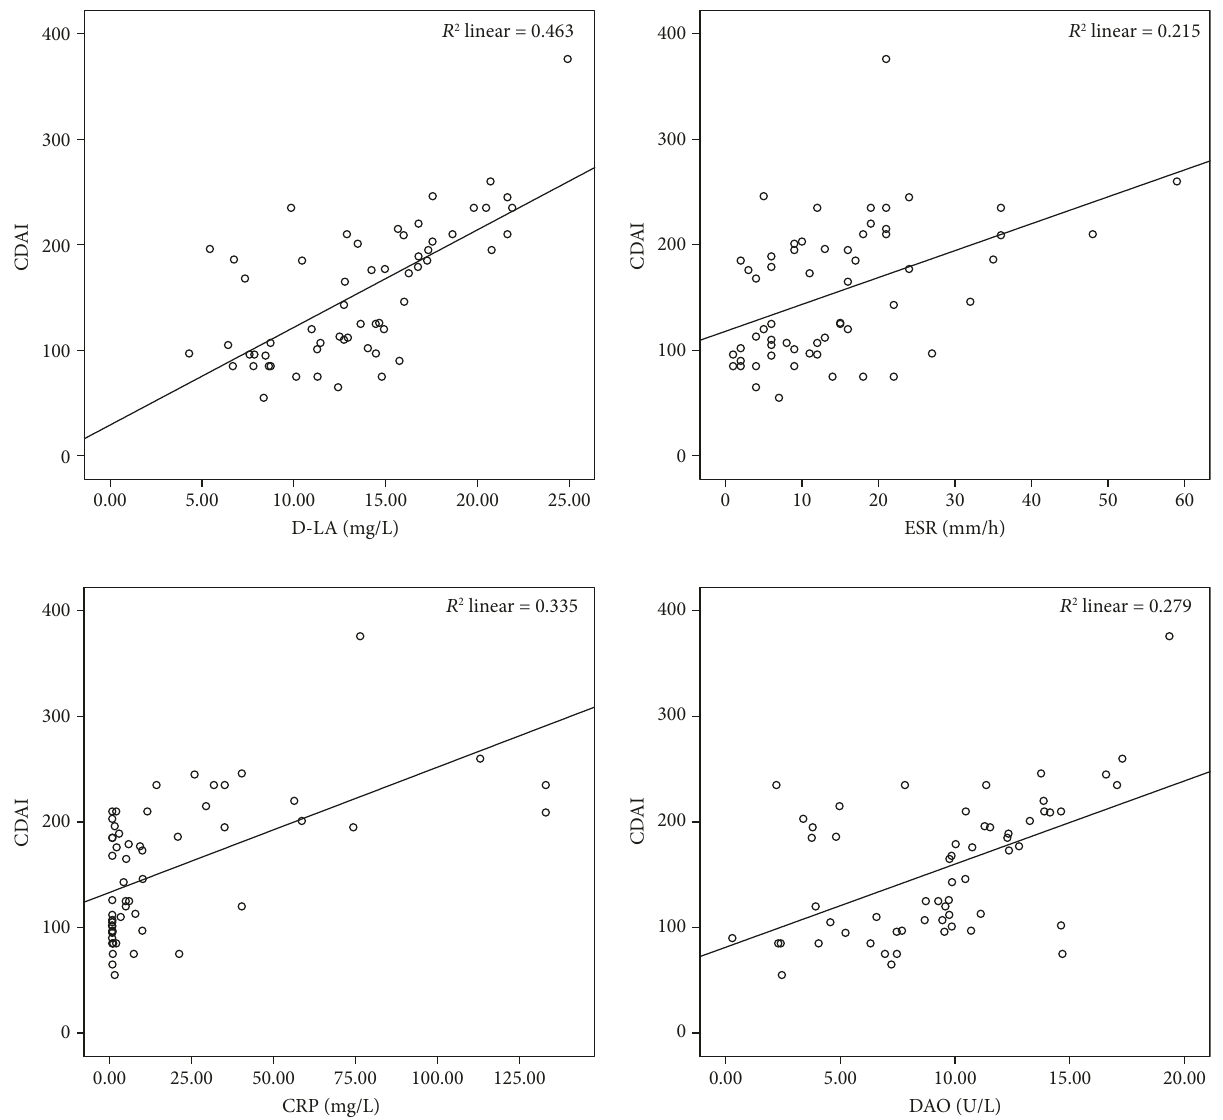
Figure 1: Correlation analysis of D-LA, DAO, ESR, CRP, and CDAI score.